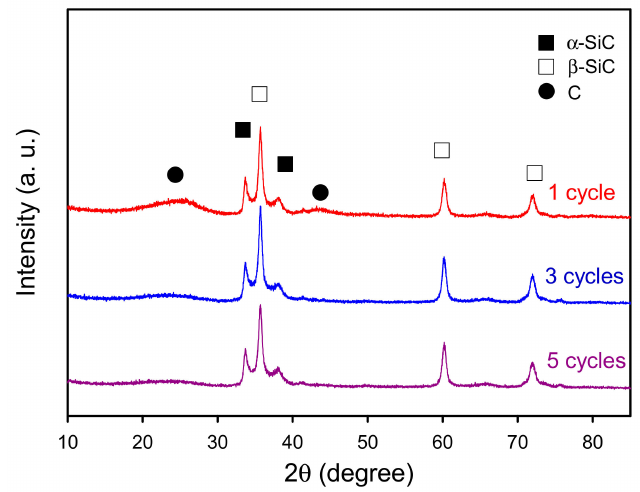
Figure 9. XRD patterns of sintered BSiCs prepared using different repeated cycles of sol–gel